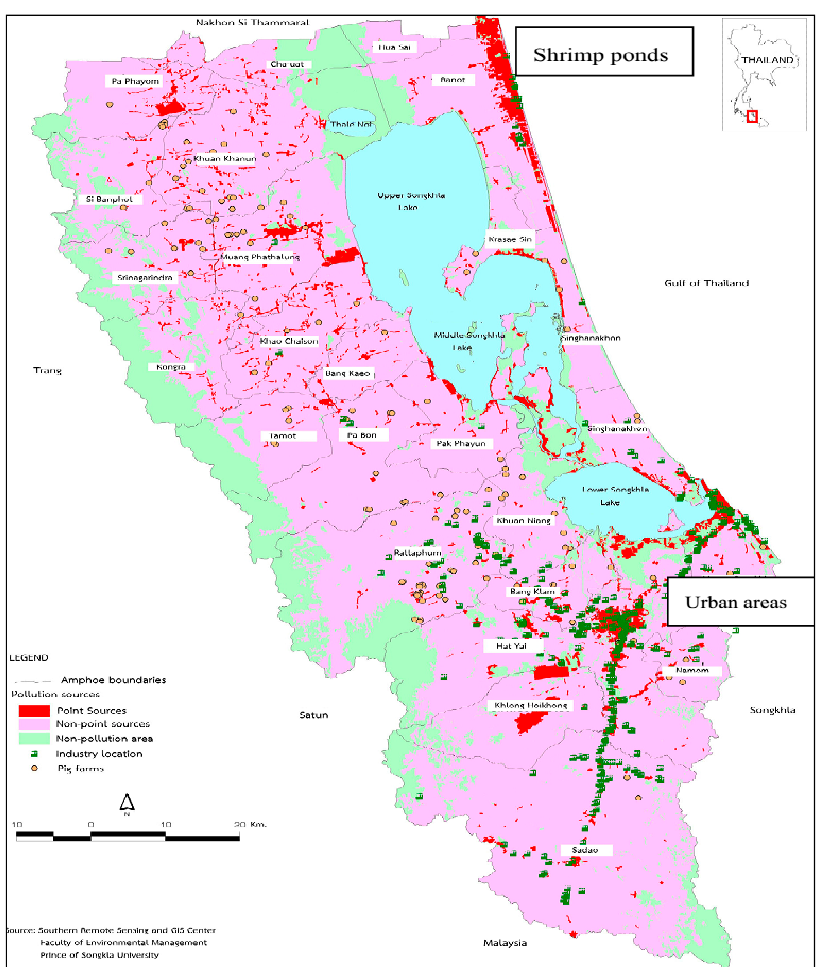
Figure 3. Map of Songkhla Lake Basin showing the lagoon system of the Songkhla Lake in Thailand, Source: [172].